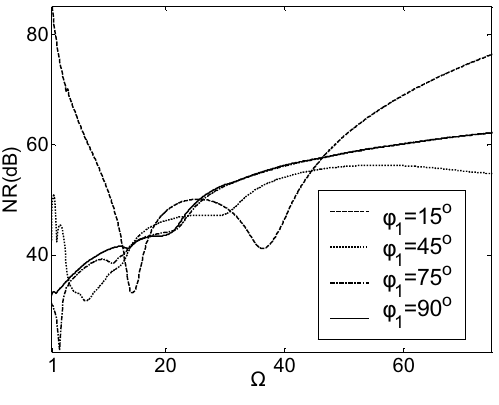
Fig. 12. Effects of incident angle of plane wave on the noise reduction for a two layered cylinder.